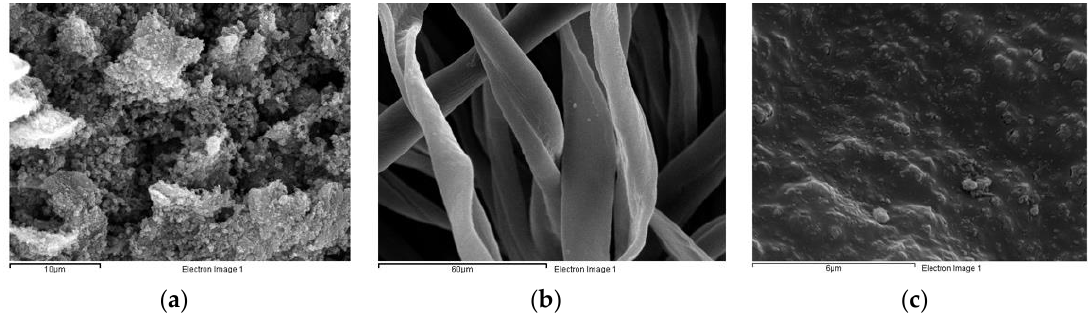
Figure 1. Representative SEM images of ( a ) UVM7-dye; ( b ) textile prior to modification; and ( c ) UVM7-cotton.